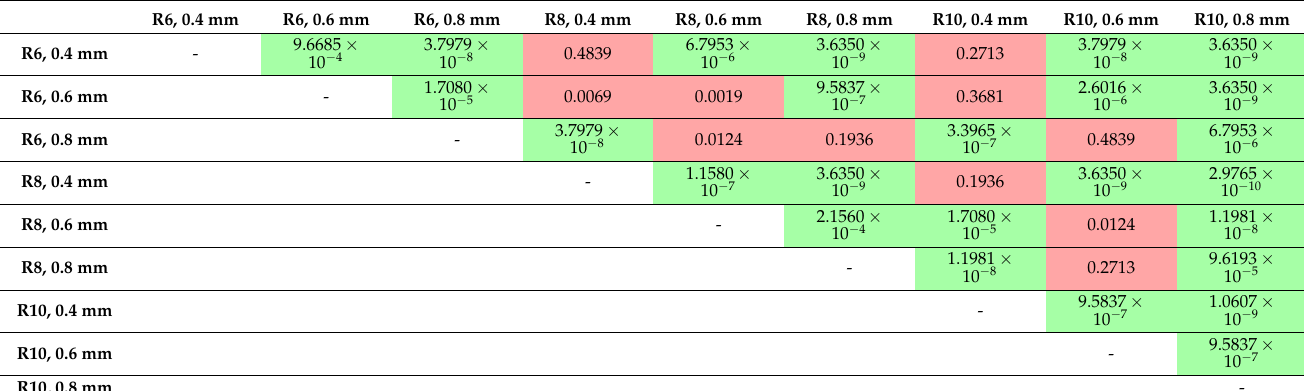
Table 1. p -Values obtained by sign test for all wood images. Green cells are those that have a statistically significant difference while red ones are those that have no statistically significant difference. Threshold used in Bonferroni correction is 0.05/36 = 0.0014.